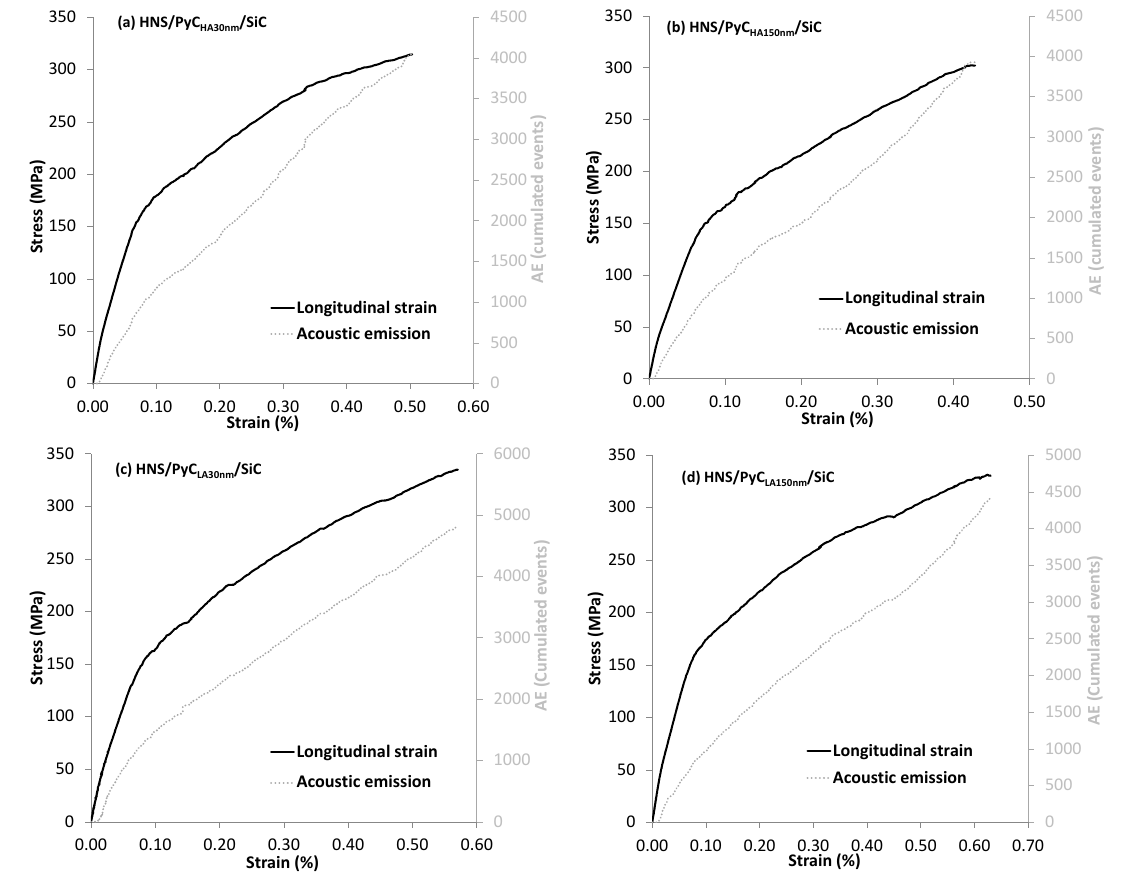
8 of 16 Table 5. Results of push-out tests on HNS reinforced composites. () standard deviation. Samples